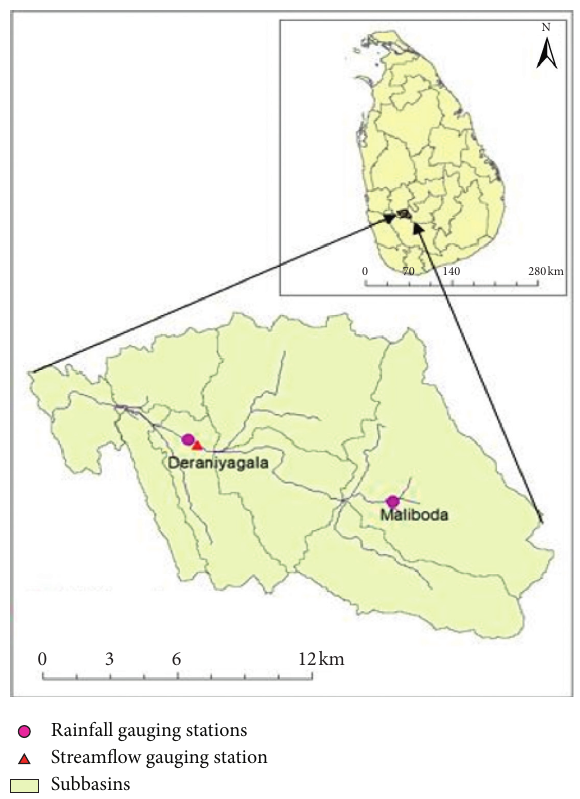
Figure 1: Location of rainfall and streamflow gauging stations in the Seethawaka